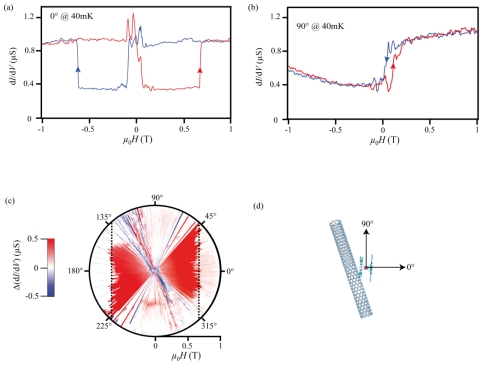
Conductance hysteresis loops of the supramolecular spin valve. (a–b) Differential conductance dI/dV measured at T = 40 mK as a function of in-plane magnetic field μ0H applied respectively along (a) the easy axis direction (0°); and (b) the hard direction (90°) of magnetization. The red and blue arrows indicate the magnetic field sweep directions; (c) Color-scale plot of the dI/dV hysteresis (obtained from the difference between both field sweep directions) as a function of the applied magnetic field angle. The white color code is associated to zero hysteresis (reproducible dI/dV curves); (d) Relative disposition of the molecule with respect to the nanotube. The magnetic hard axis is 30° tilted from the nanotube axis.